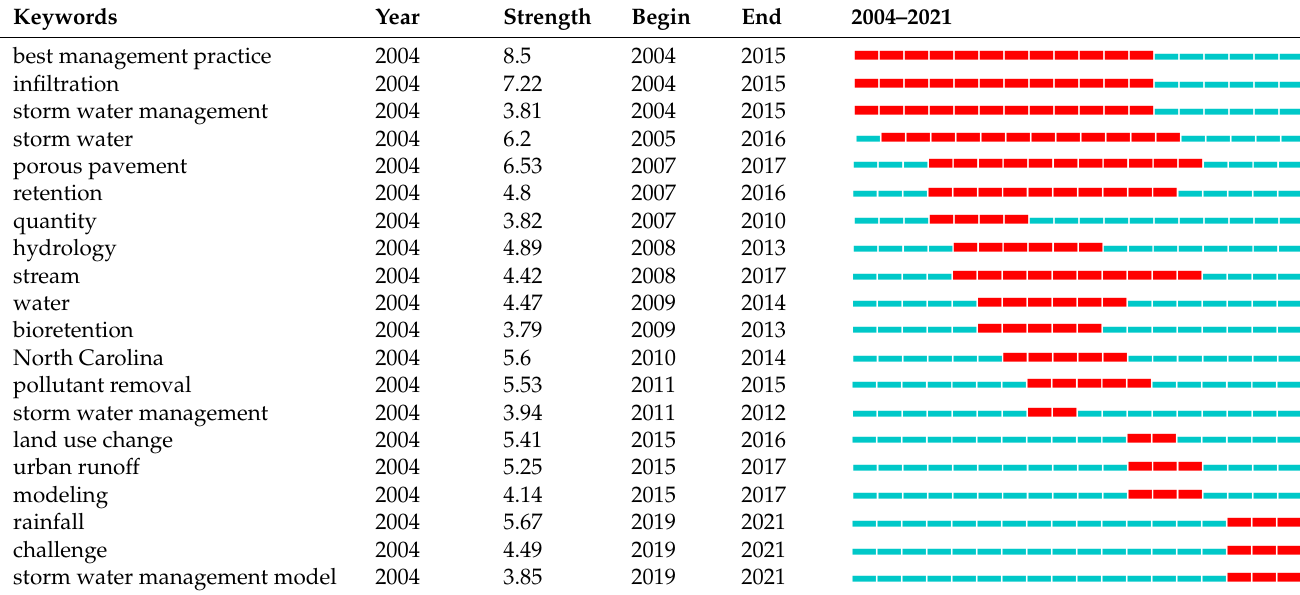
Table 4. Keywords burst detection of publications based on the WOS database.